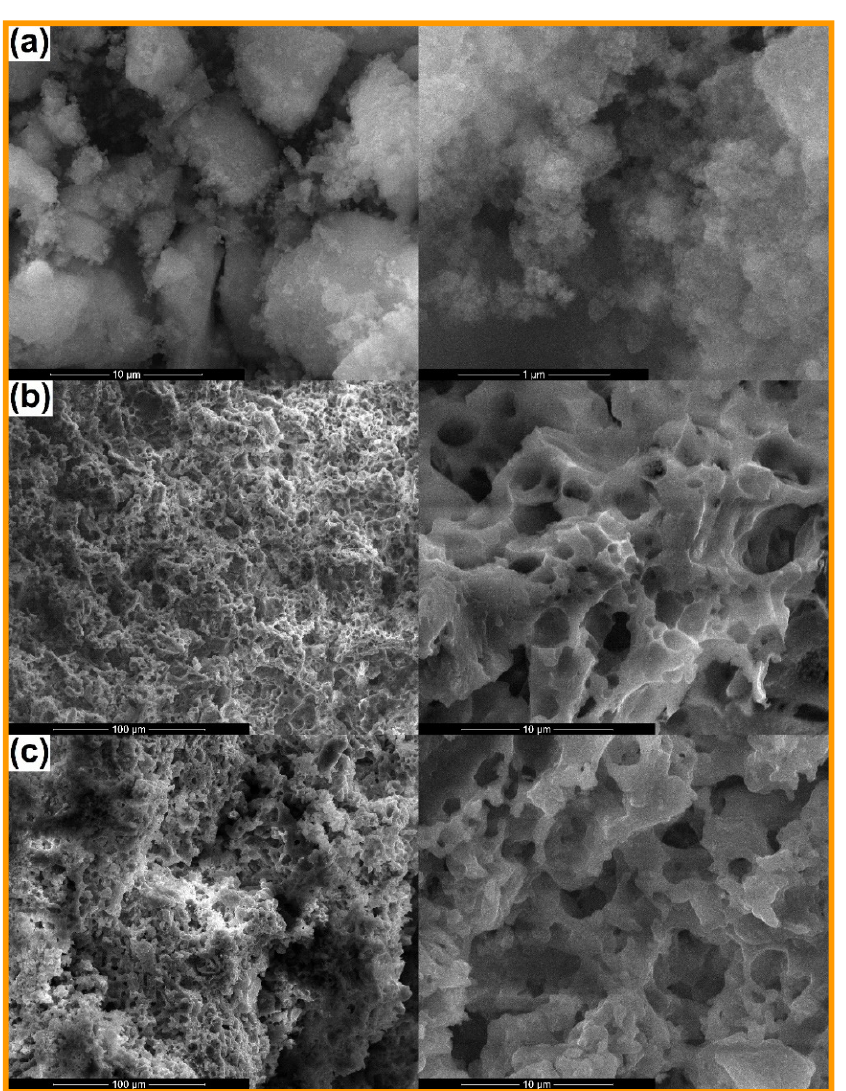
Figure 2. SEM images of: ( a ) Ce calcined powder (10,000 × and 100,000 × ), ( b ) Ce-1000 sintered scaffold (1000 × and 10,000 × ) and ( c ) Ce-1200 sintered scaffold (1000 × and 10,000 ×